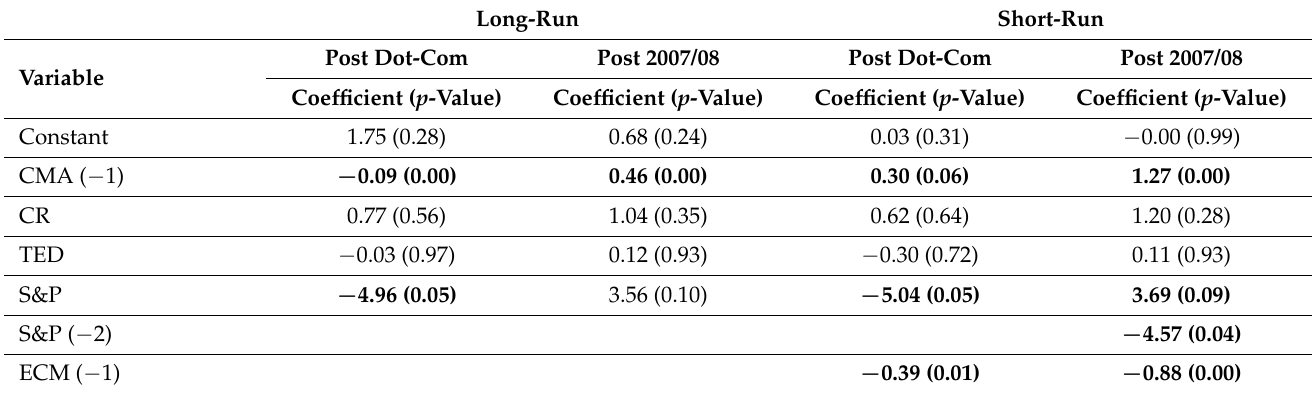
Table 20. Long-run ARDL model and short-run error correction model for CMA